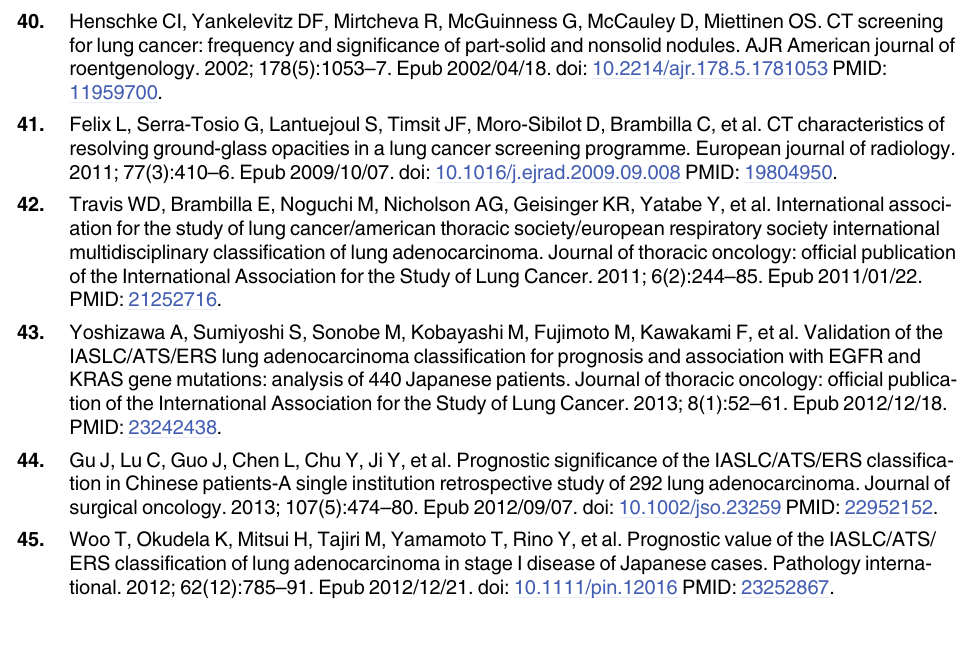
PLOS ONE | DOI:10.1371/journal.pone.0136727 August 28,